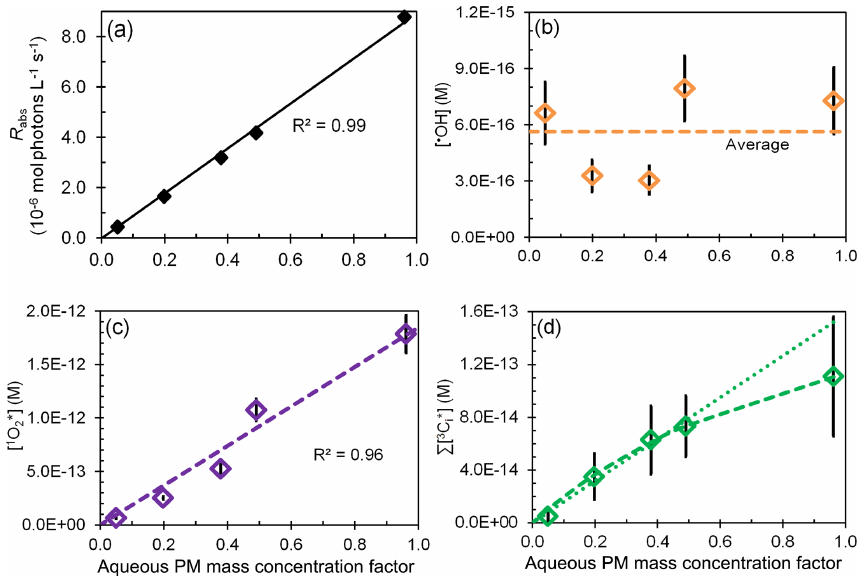
Figure 4. Effect of change in aqueous particle mass concentration (i.e., sample dilution) for sample PME3 on (a) rate of light absorption and the steady-state concentrations of (b) hydroxyl radical, (c) singlet molecular oxygen, and (d) oxidizing triplet excited states of organic matter. The last panel shows both linear (dotted) and hyperbolic (dashed) fits to the data. In each plot the x axis is a measure of sample dilution, with higher concentration factors corresponding to more concentrated particle extracts (Eq.